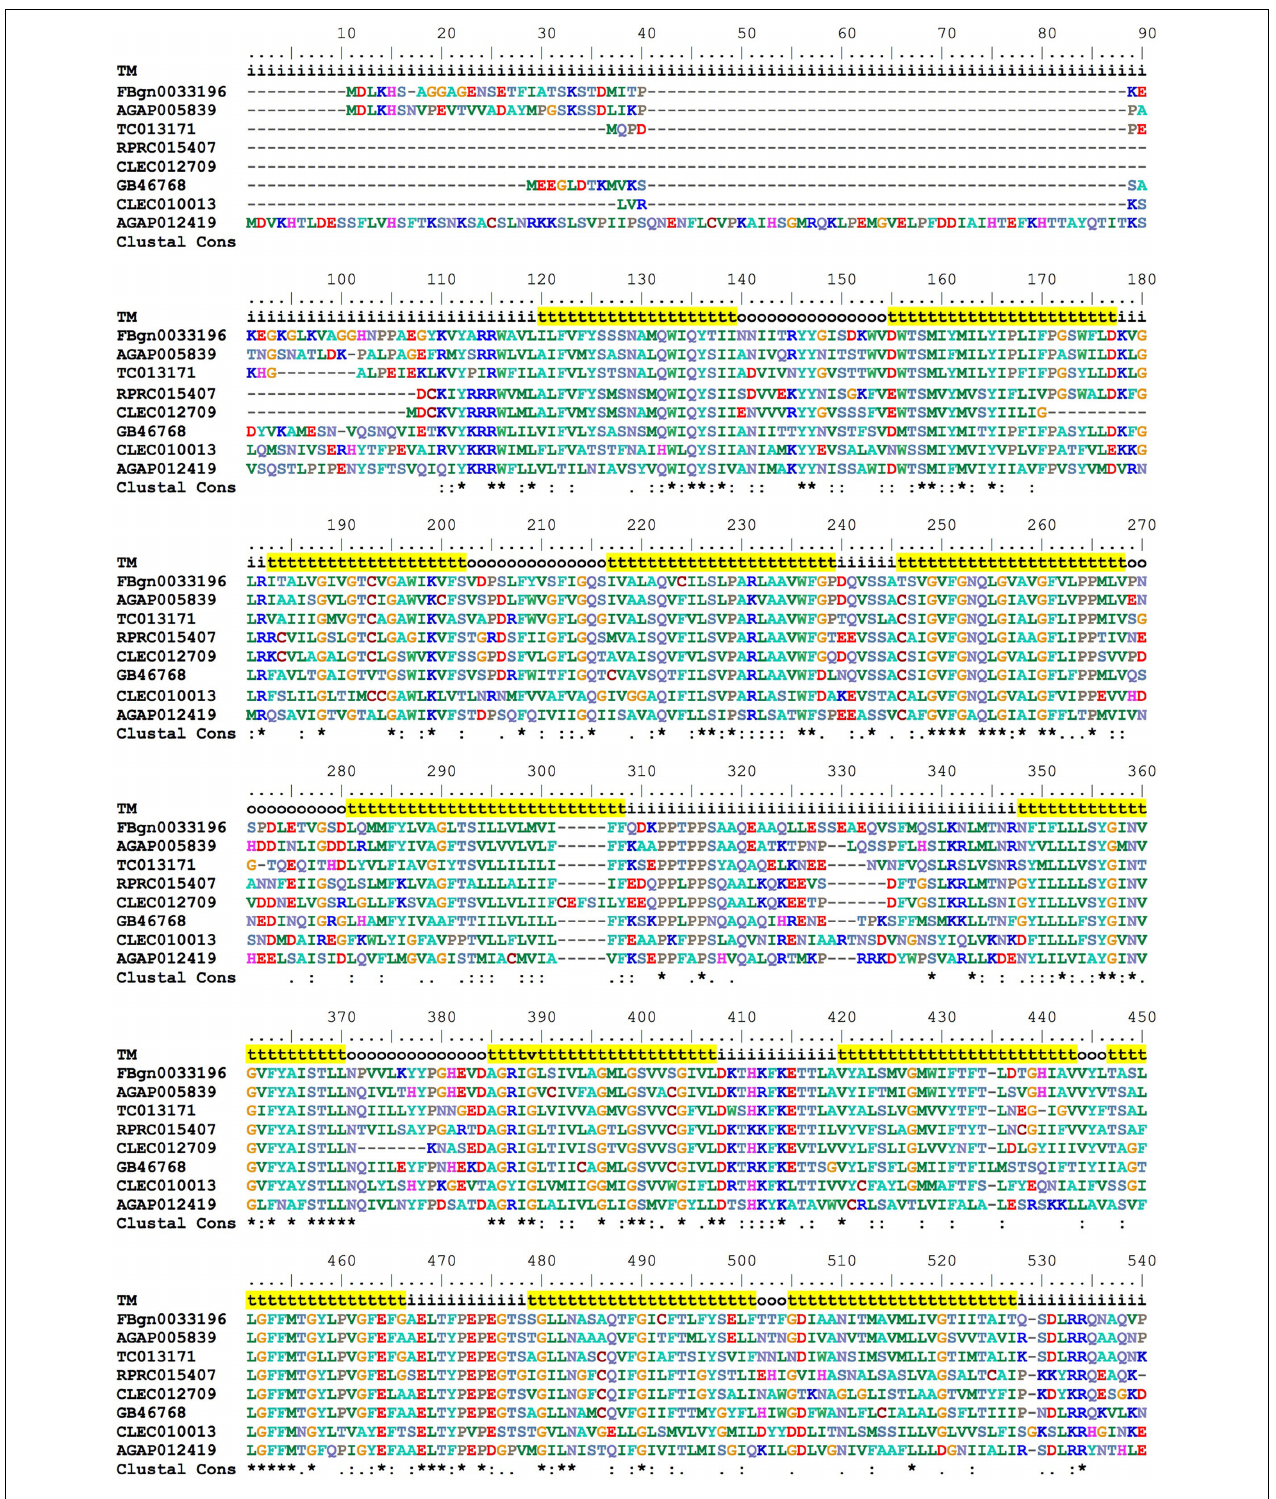
FIGURE 9 | Multiple amino acid sequence alignment of R. prolixus FLVCR. BioEdit “ClustalW” aminoacid color code was used. Consensus residues (“Clustal cons” line) were generated by ClustalW. “TM” lines indicate transmembrane regions by yellow background “t”, inside (i) and outside (o) loops. The non-conserved C-terminal region (36 residues - position 541 to 576) was omitted to improve the conserved sequences comparison.